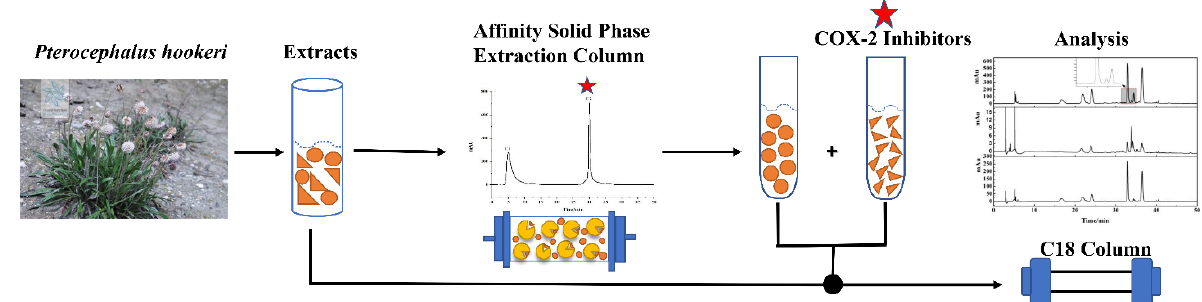
Figure 2. Schematic illustration of the affinity solid-phase extraction HPLC system for screening COX-2 inhibitors from Fr-3 of P. hookeri. The orange shapes represent compounds in Fr-3, and the yellow shapes represent COX-2 (human, recombinant).